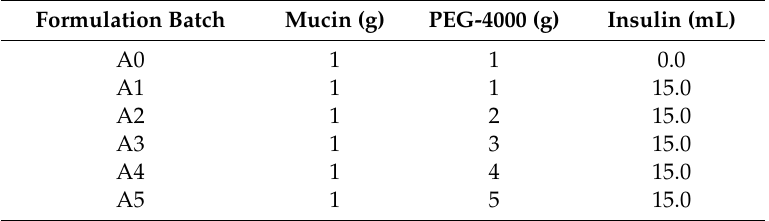
Table 1. Formulations based on di ff erent ratios of mucin and PEG-4000 used for preparing insulin-containing microparticle-based